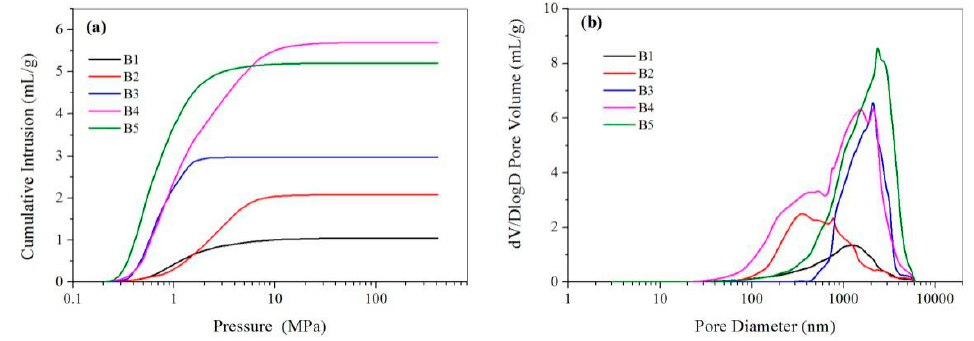
Figure 8. ( a ) Cumulative mercury intrusion traces and ( b ) pore size distribution of the CMC/CA microspheres fabricated with W1/O ratios of 10/100 (B1), 30/100 (B2), 50/100 (B3), 70/100 (B4), and 90/100 (B5).